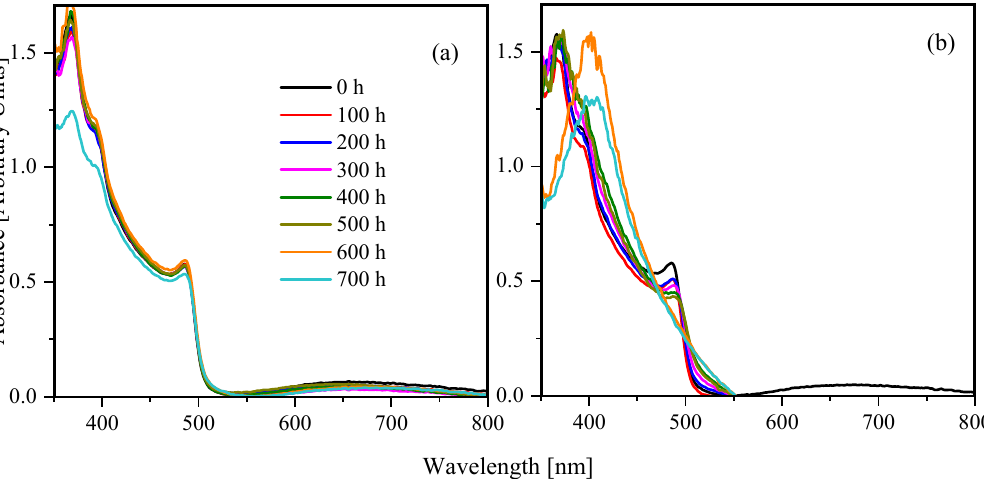
Figure 1. Evolution of the absorption spectra of MAPbBr3 films exposed to white light with a power of 100 mW/cm 2 at 10 °C ( a ) and 60 °C ( b ).